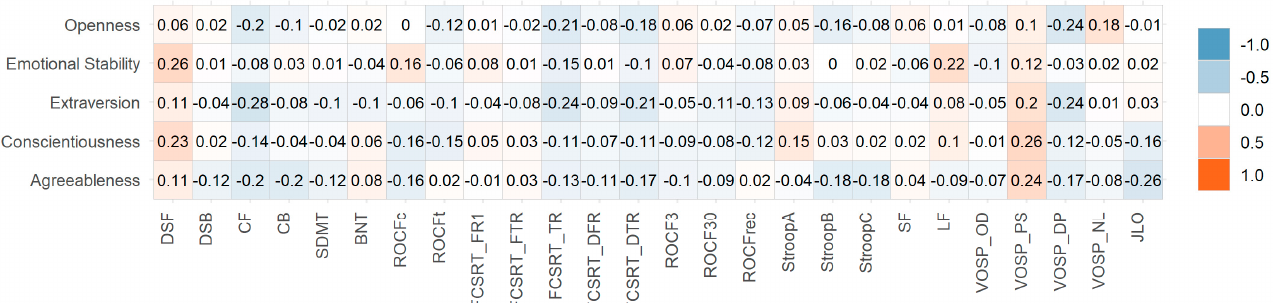
Figure 1. Heatmap of Pearson correlation coefficients between personality factors and scales.